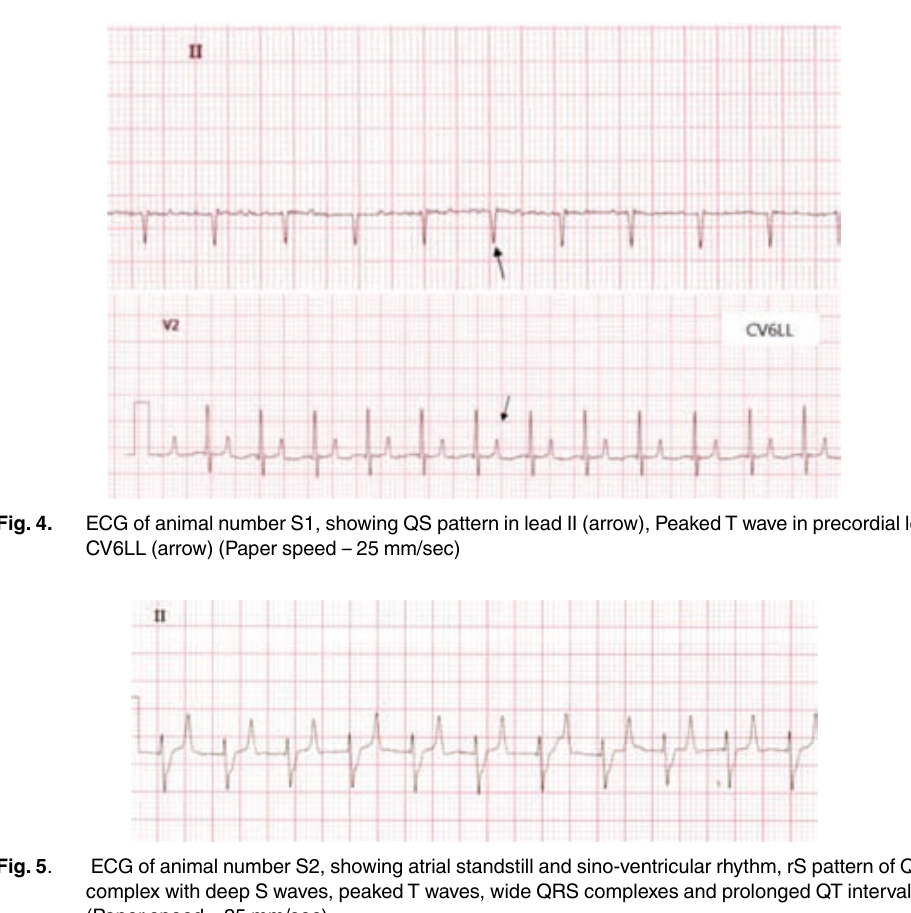
Fig. 3c. Normal sinus rhythm (precordial chest leads) (Paper speed – 25 mm/sec)